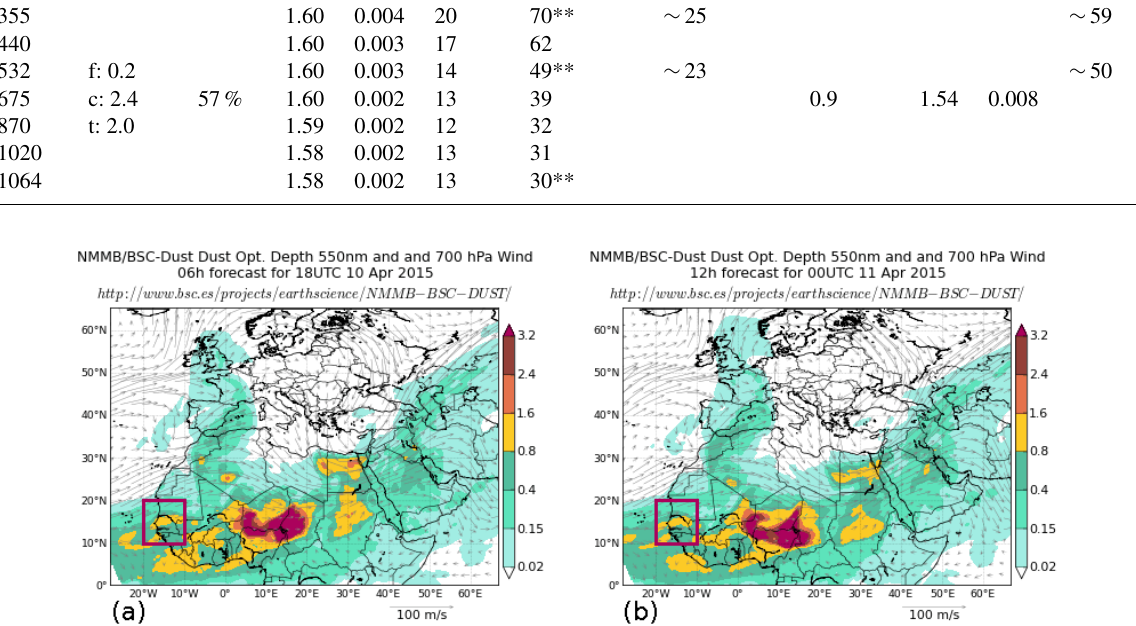
Figure 11. NMMB/BSC-Dust model results over Africa and Europe on 10 April 2015. AOD values forecasted by the model ranged from 0.8 to 1.6 at 550nm. (a) 18:00UTC, 10 April; (b) 00:00UTC, 11